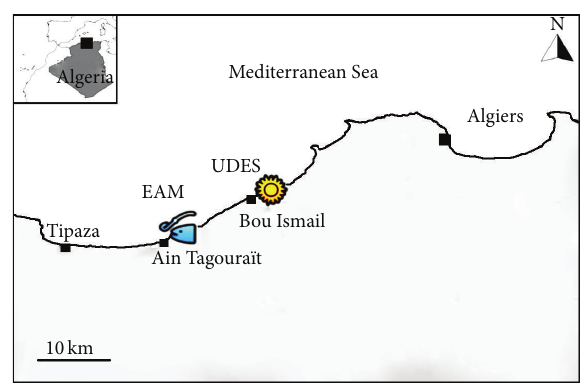
Figure 1: Geographical area of the